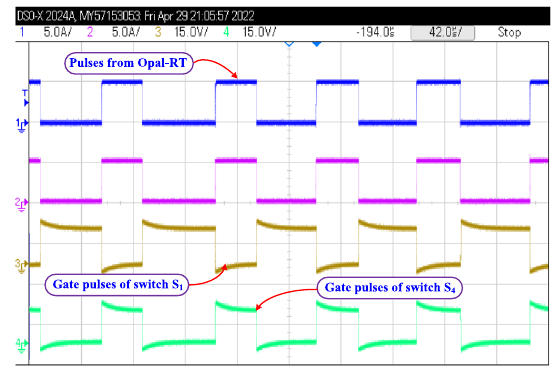
Fig. 28 Switch S1 and S4 gate pulses for IGBTs [pulses from Opal-RT (Ch1), pulses after isolation (Ch2), switch S1 gate pulses (Ch3), and S4 switch gate pulses (Ch4)]